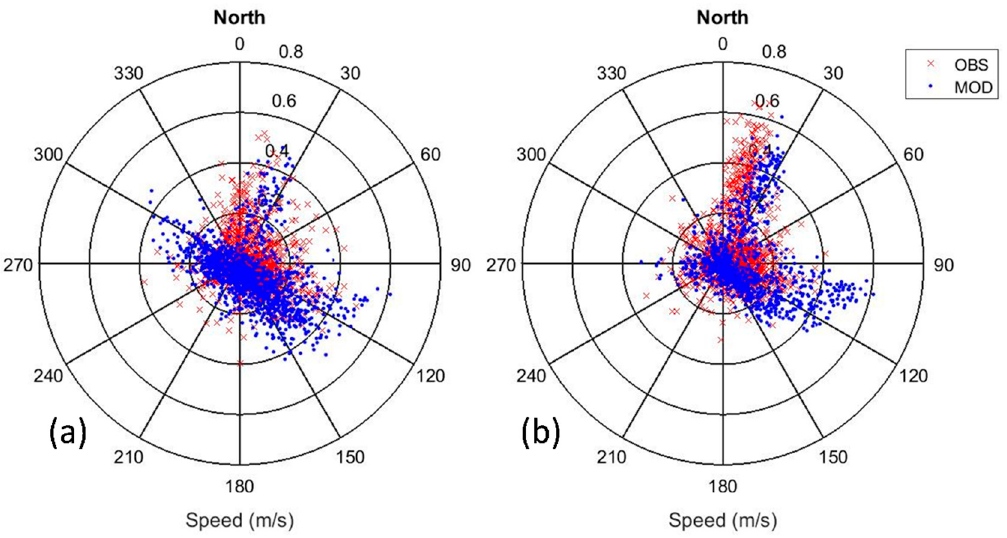
Figure 14. Model results (blue dots) of near-bottom ocean current vectors between 1 November and 31 December 2014, compared with ( a ) ADCP data (red crosses) at 181 m and ( b ) DVS data (red crosses) at 196 m.